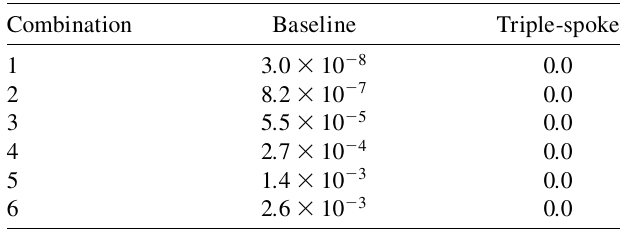
TABLE III. Beam losses for the error combinations of Table II and both the baseline and triple-spoke designs of the driver linac. The losses at the collimators following both strippers (MTS-1–2) are controlled losses. They are in the (cid:4) 2 – 4 (cid:7) (cid:6) 10 (cid:1) 3 range and vary slightly with the error combina- tion.